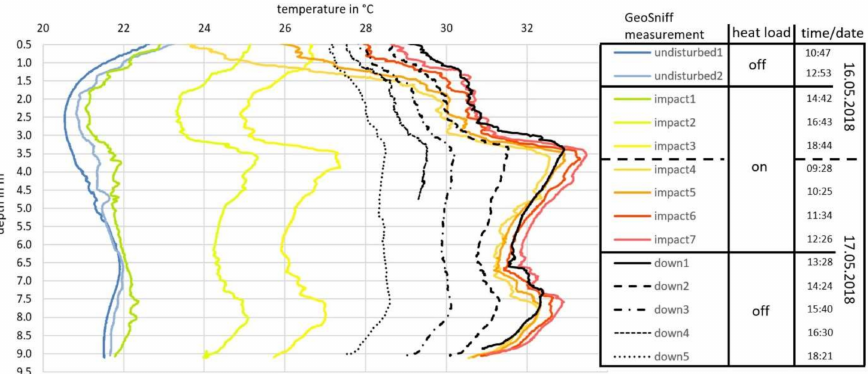
Figure 7. Plot of the temperature profiles measured before, during, and after applying the heat load. All temperatures were recorded within the additionally inserted single-U